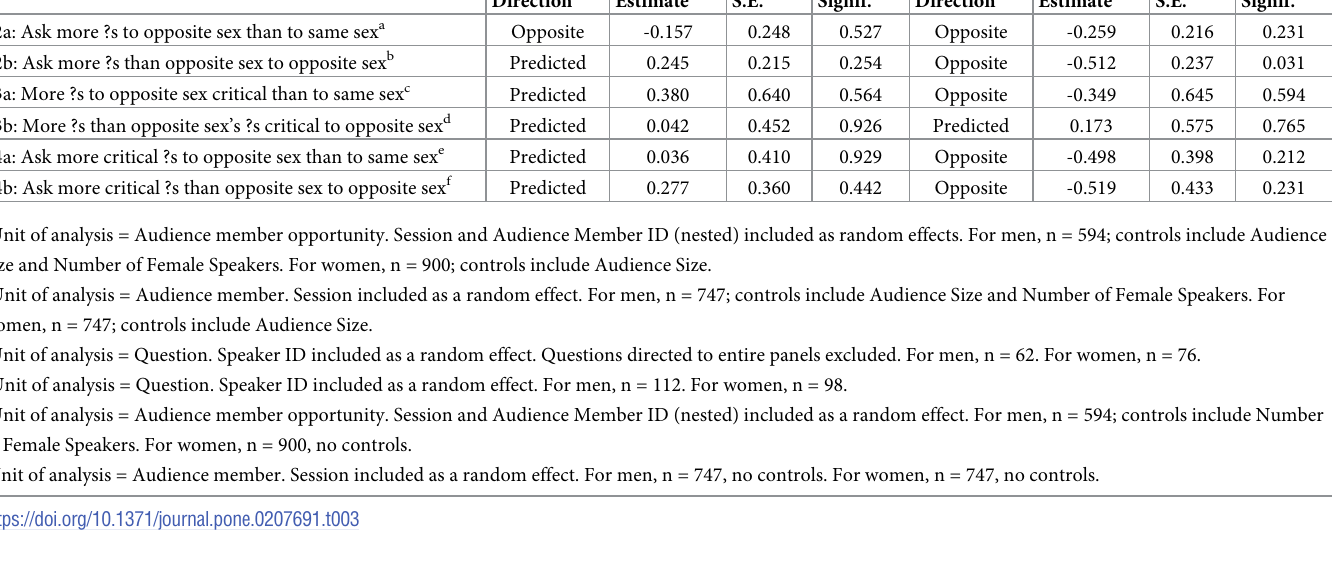
Table 3. Results of mixed logistic models testing predicted effects. Male Audience Members Female Audience Members Direction Estimate S.E. Signif. Direction Estimate S.E.